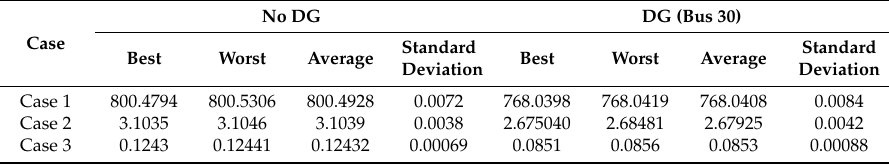
Table 5. Statistical results obtained over 50 independent trials of Jaya method without and with employing